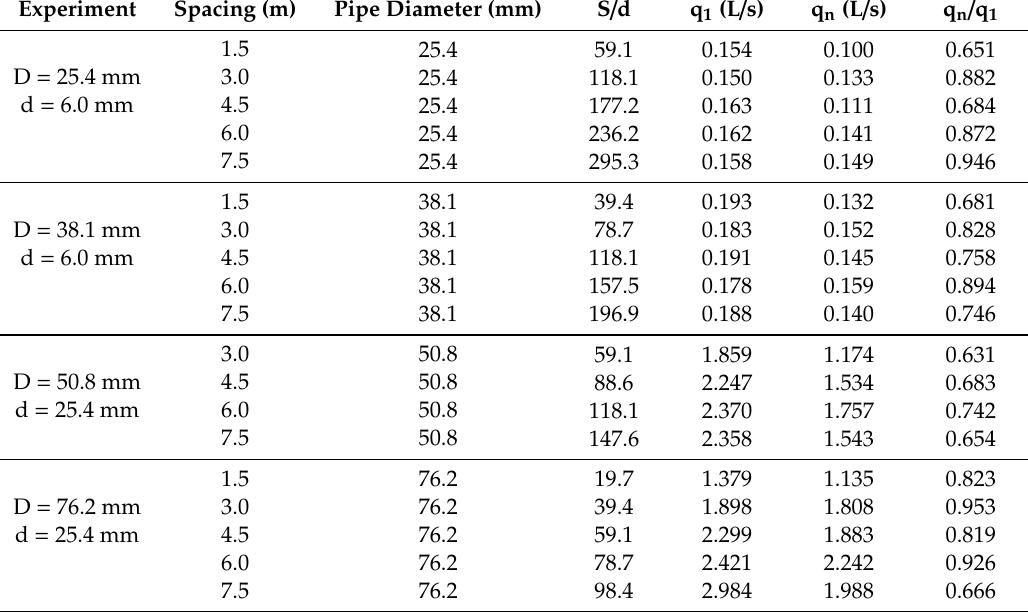
Figure 10. Variation of the friction ratio for various outlet spacings (Inlet head = 2.2 m). Table 2. Calculated uniformity coe ffi cient for 2.2 m inlet